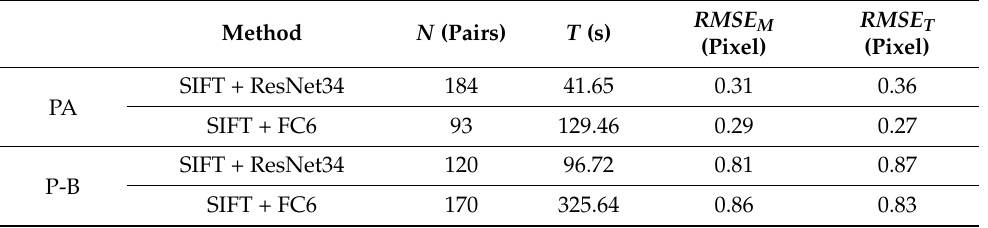
Table 6. Experimental results for different